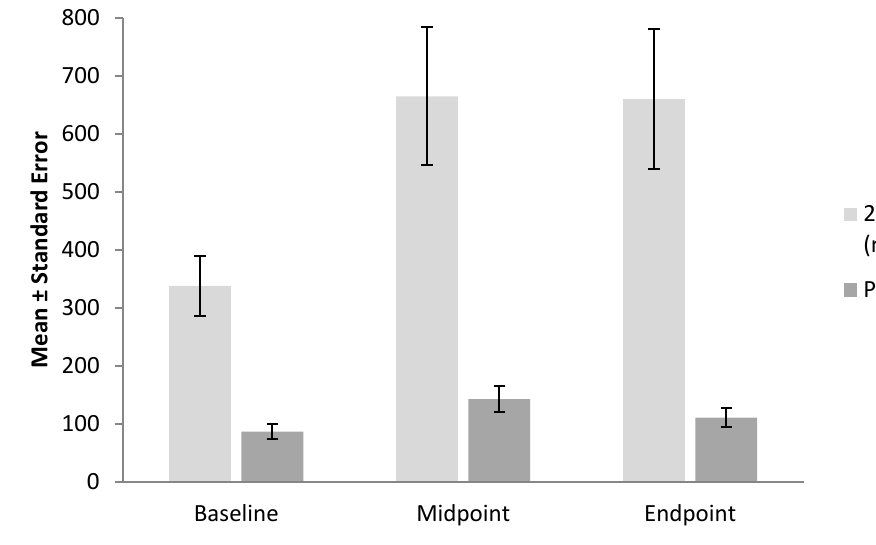
Figure 2. Aluminum absorption during calcium citrate treatment in 26 subjects. Midpoint equals 19 ± 6 days; endpoint equals 38 ± 14 days. Data were derived from Nolan et al.